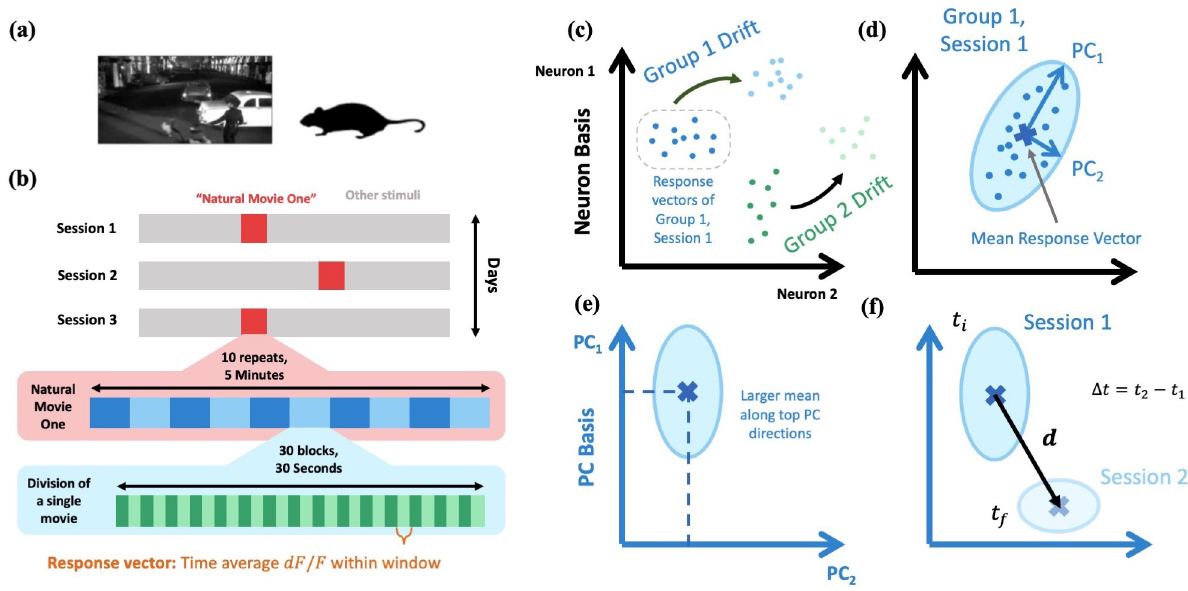
Fig 1. Setup of passive data and visualization of feature space representations. (a) Summary of passive data experiment. (b) Summary of response vector extraction across three imaging sessions. [c-f] Visualization of feature space representations. (c) Drift of response vectors belonging to two separate stimulus groups between two sessions. For example, stimulus group 1 might corresponding to the response vectors of the 0 to 1 second time-block of Natural Movie One and stimulus group 2 the 1 to 2 second time-block. (d) For each stimulus group in each session, we perform PCA to characterize the group’s variation. An important quantity is also the group’s mean response vector. (e) Moving to the respective stimulus group’s PC basis, there is a strong correlation between the variance and mean value along a given direction, familiar from Poisson-like distributions. (f) The aforementioned feature space characterization is used to quantify drift. We define the drift vector, d , of a given stimulus group as pointing from the mean response vector of an earlier session (e.g. Session 1) to the mean response vector of a later session (e.g. Session 2). Δ t is the time difference between the sessions.